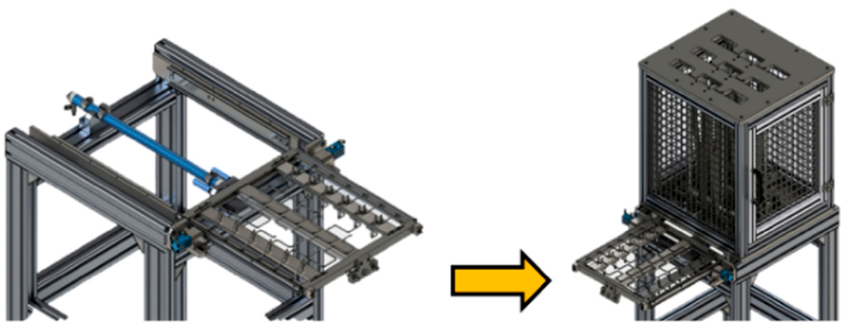
Figure 6. The wire storage tower ( right ) and movable drawer ( left ).